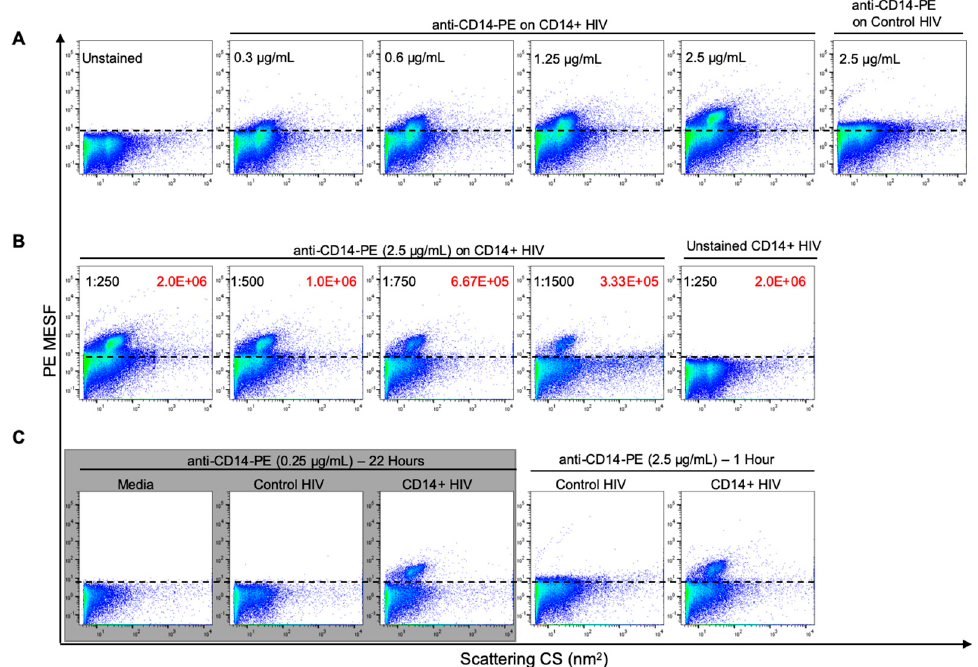
Figure 3. Optimization of antibody labeling protocol for phenotypic analysis of HIV pseudoviruses by flow virometry. ( A ) Titration of an anti-CD14-PE antibody on CD14 + HIV, stained for 1 h at room temperature (RT). Unstained virus and a control virus (without CD14) stained at the maximum concentration (2.5 µ g / mL) of antibody tested are shown for comparison. ( B ) Dilution series of CD14 + virus labeled with 2.5 µ g / mL of anti-CD14-PE to demonstrate reduction of background fluorescence from coincidence. Virus dilutions are shown in black, with associated particle concentrations (particles / mL) shown in red. ( C ) Reduction of coincidence through ten-fold reduction in antibody concentration and increased staining time, as seen when comparing the data in the grey box (left three plots) to the right panel (two plots). The staining time was increased from 1 h at RT to overnight at 4 ◦ C to obtain an equivalent level of labeling as seen in ( B ). This optimized protocol (denoted with the grey box) was used for all subsequent staining procedures. Events above the dashed lines indicate positive labeling or increased background fluorescence due to coincidence. This line was set directly above the level of background fluorescence seen on unstained virus or cell culture media. For each panel, a range of dilutions were tested to ensure that the observed results were reproducible across multiple conditions and were not due to